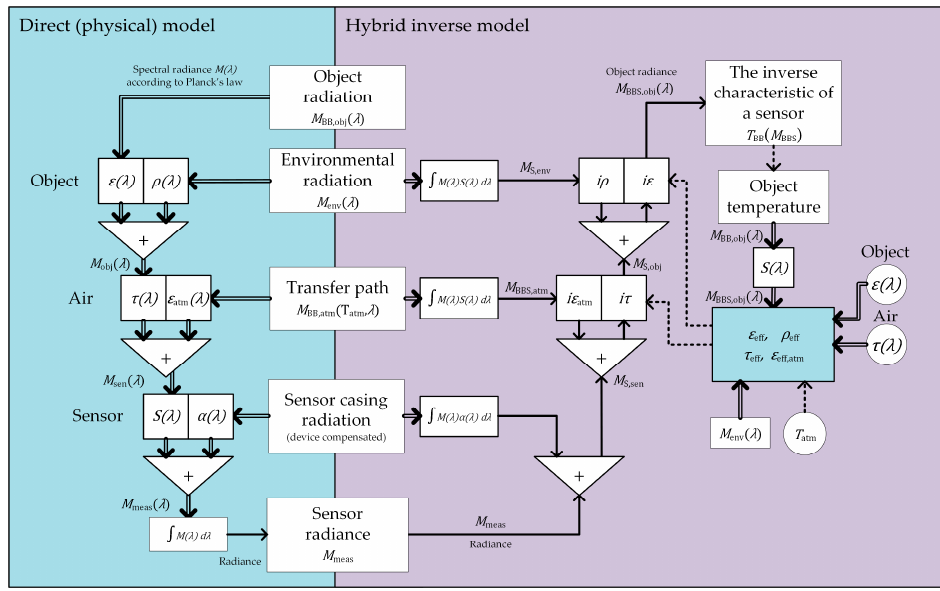
Figure 12. Hybrid inverse model utilizes effective parameter calculation according to spectral radiances in the system of measurement.